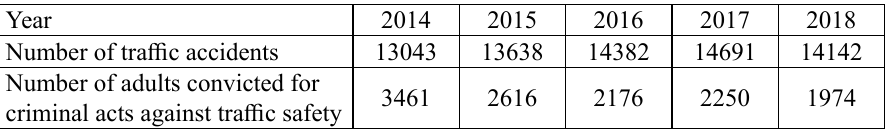
Table 1 : Number of traffic accidents and persons convicted for criminal acts against traffic safety 14 in period